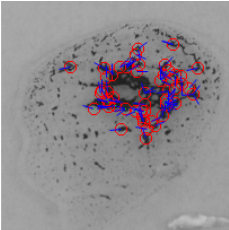
Figure 16. Features points and its orientation for the reference image using SIFT algorithm.